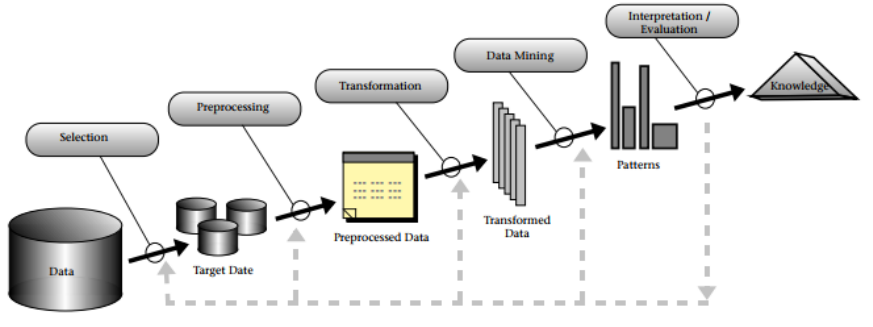
Figure 1. Knowledge discovery